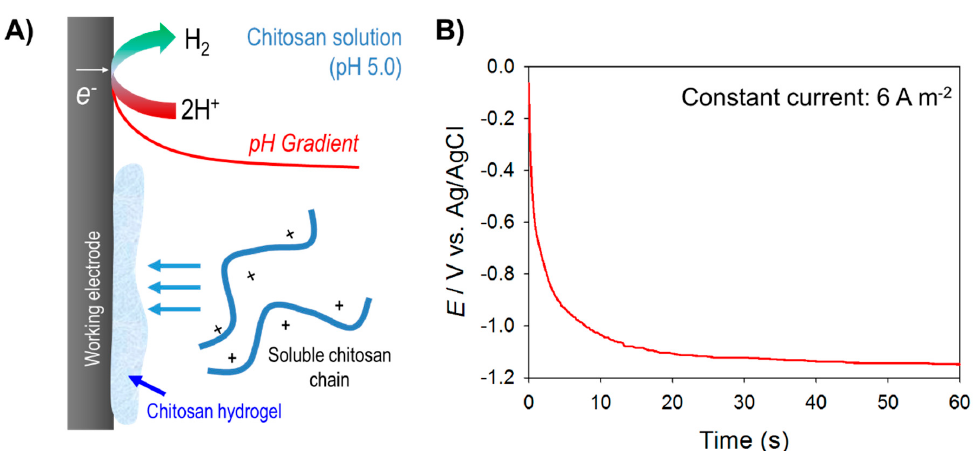
Figure 4. ( A ) Electrodeposition of chitosan hydrogel. ( B ) Chronopotentiometry data for chitosan hydrogel formation on carbon cloth anode.